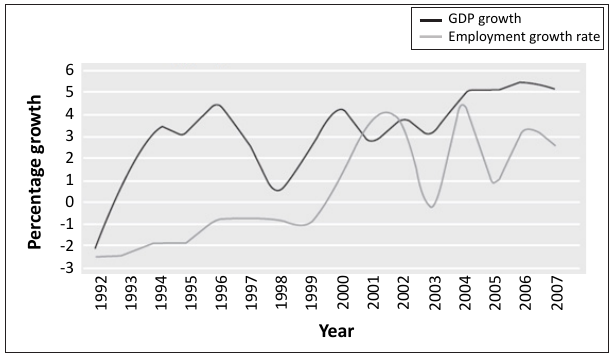
FIGURE 1: Economic growth outpaces employment